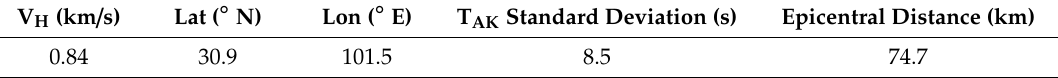
Table 3. Location of the CID source based on the ray-tracing